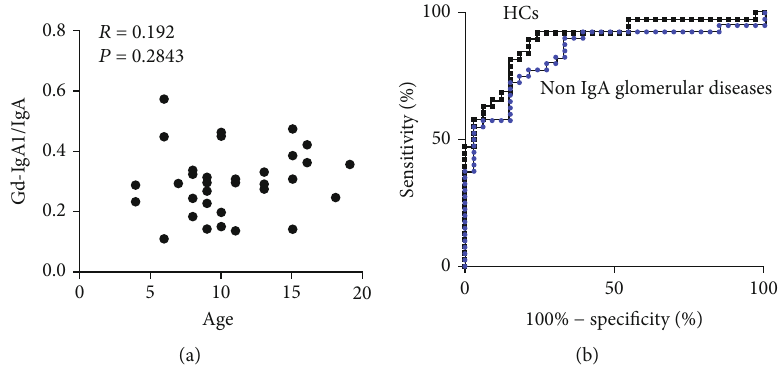
Figure 4: Serum Gd-IgA1/total IgA ratio as an age-independent biomarker for the di ff erentiation between IgA nephropathy and non-IgA glomerular disease. (a) Correlation between age and serum Gd-IgA1/total IgA ratio. (b) The receiver operating characteristic curve analysis of the serum Gd-IgA1/total IgA ratio for di ff erentiating IgA nephropathy from other non-IgA glomerular diseases and healthy 95% con fi dence interval were 0.8915 and 0.8149 – 0.9682,